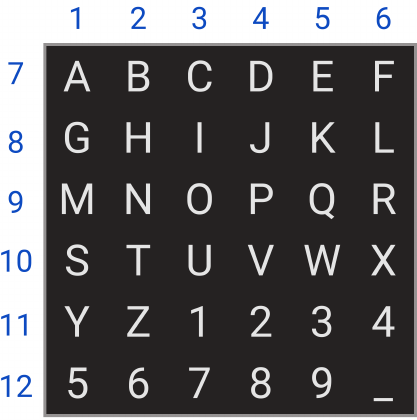
Figure 1. Classical 6 × 6 GUI matrix of P300 speller: 12 rows and columns are flashing one by one randomly. A single trial has two target intensifications out of twelve possible flashing rows and columns. By finding the intersection of the target row and column, the chosen character is